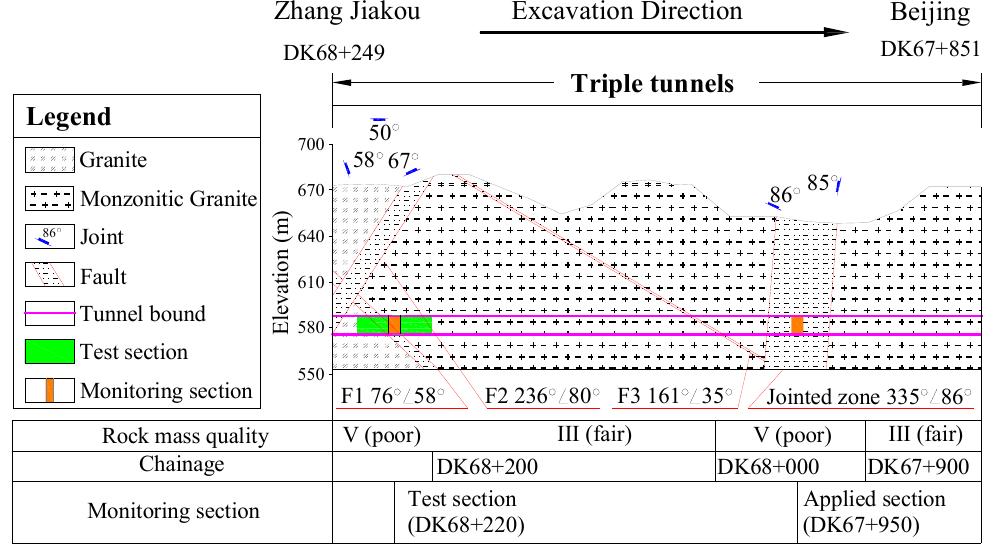
Figure 1. Geological profile of triple tunnels.